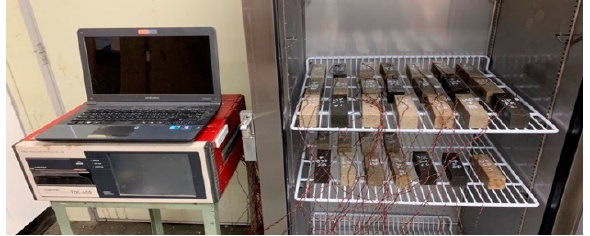
Figure 5. Test setup for measuring thermal expansion.